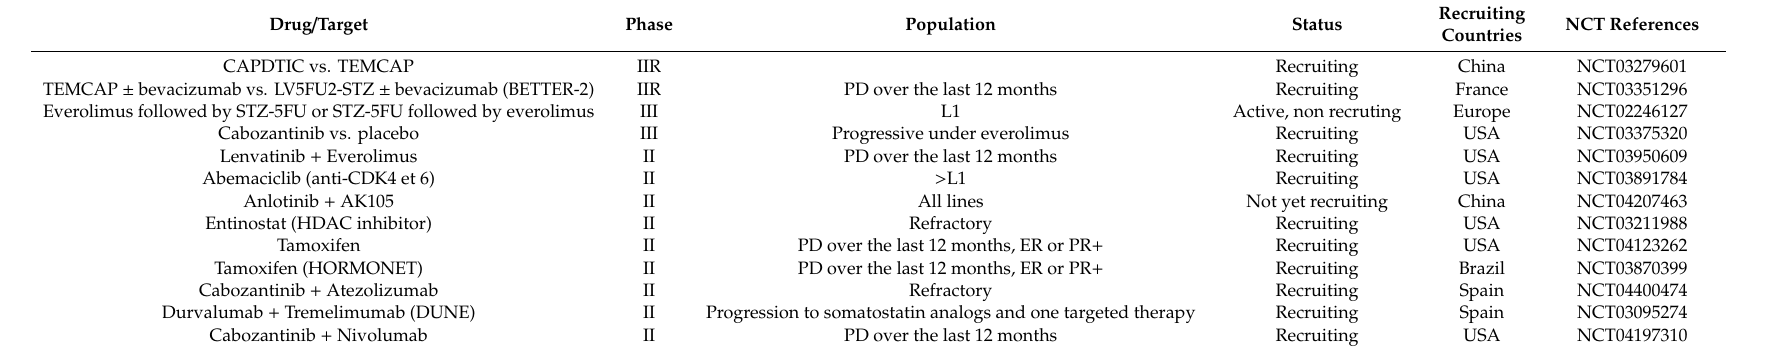
Table 1. Selected ongoing clinical trials on medical treatments in advanced / metastatic